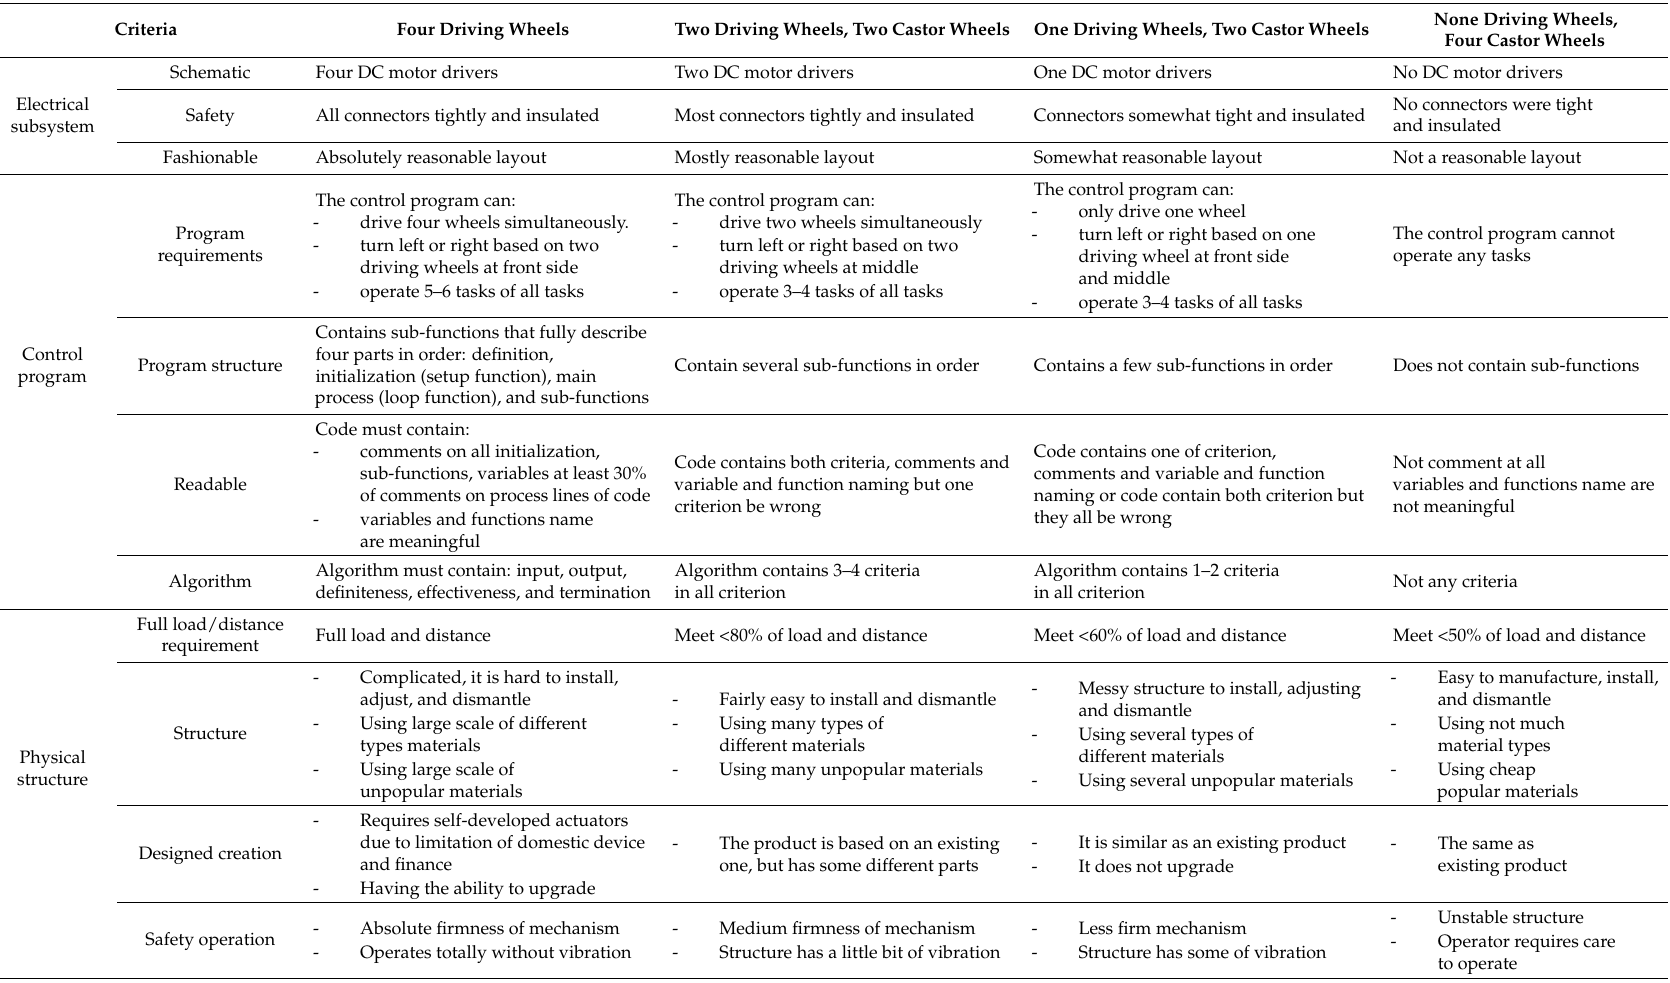
Table A1. Evaluations of Design